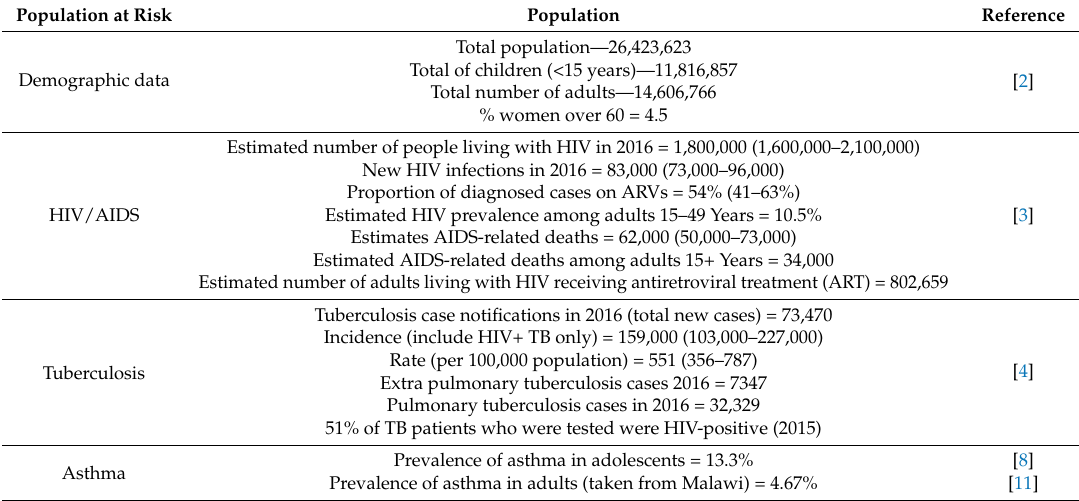
Table 1. Country’s profile. Population and rates required to calculate burden of serious fungal infections